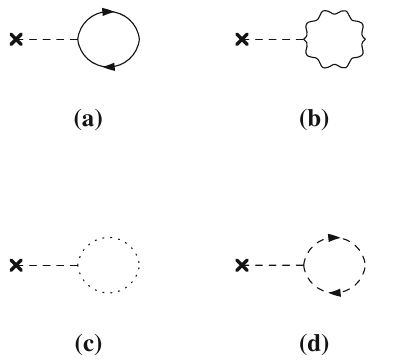
Fig. 1 Feynman diagrams contributing to the tadpole residue to one- loop order. The straight ( a ), wiggly ( b ), short-dashed ( c ), and long- dashed lines stand for fermion, vector boson, scalar, and ghost contri- butions, respectively